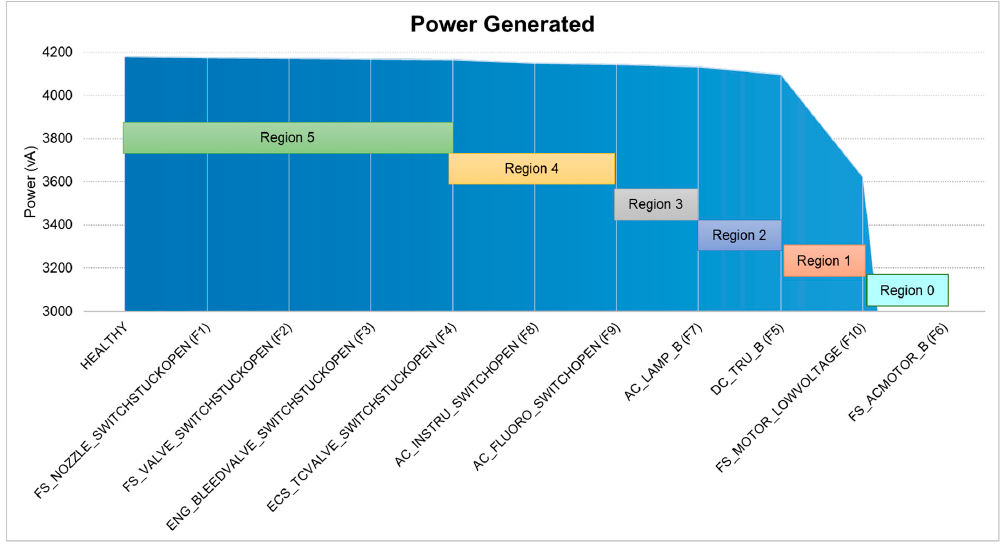
Figure 8. Healthy and faulty scenarios classified based on apparent power generated using the crisp boundary approach.